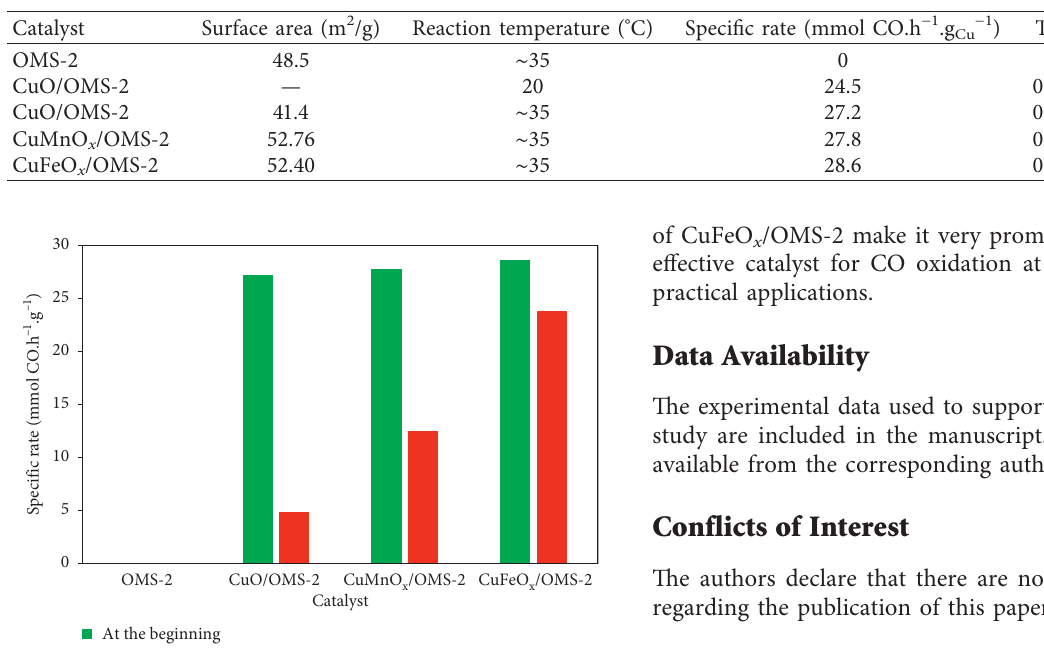
Table 3: Performance of catalysts for CO oxidation.